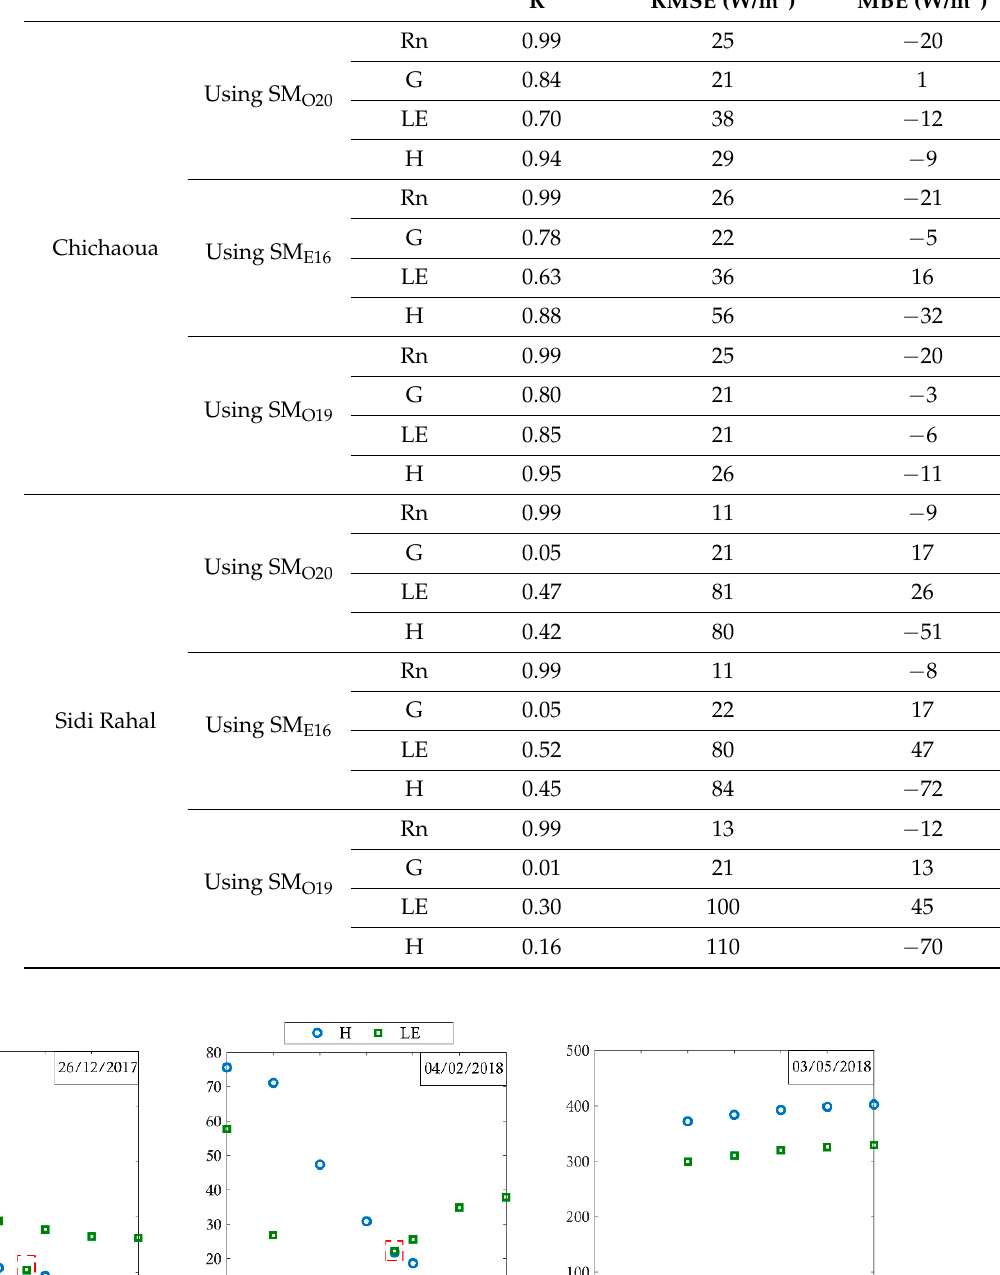
Table 3. Statistical results (RMSE, R 2 , and MBE) between the modeled and measured net radiation, conductive, latent, and sensible heat fluxes for Chichaoua and Sidi Rahal by applying the TSEB-SM model for the three SM retrieval approaches, separately.